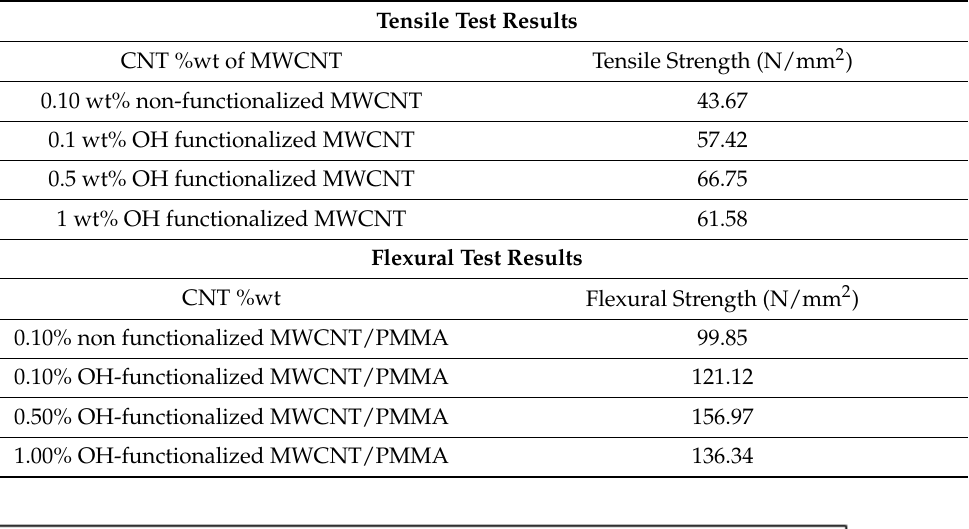
Table 2. Summary of Tensile and Flexural Test of 0.1 wt%, 0.5 wt% and 1.0 wt% loading of hydroxyl functionalized MWCNT in PMMA.